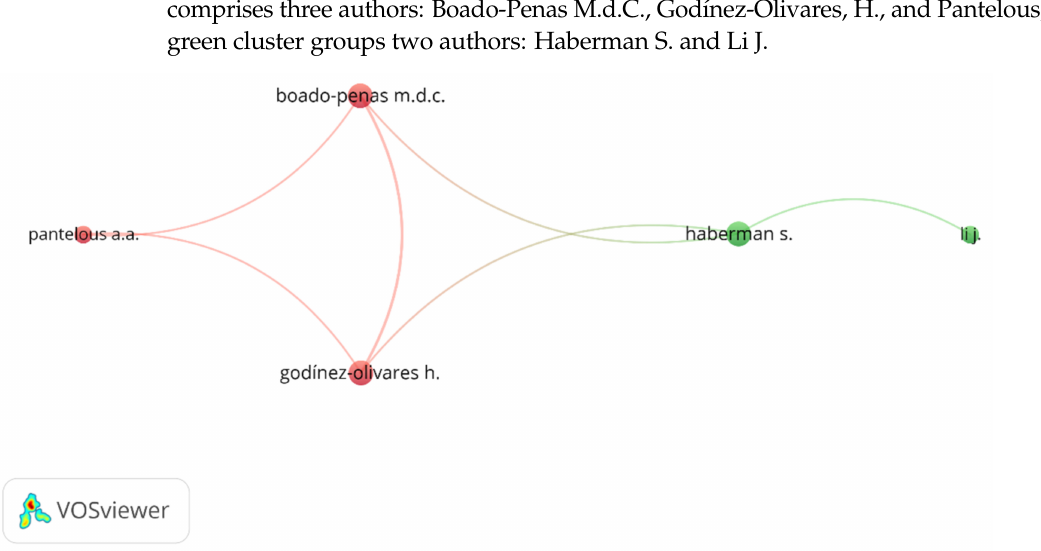
Figure 13. Network of cooperation based on co-authorship of the main authors in the Mathematics area. Source: own elaboration.